Question: State the chart type depicted above.
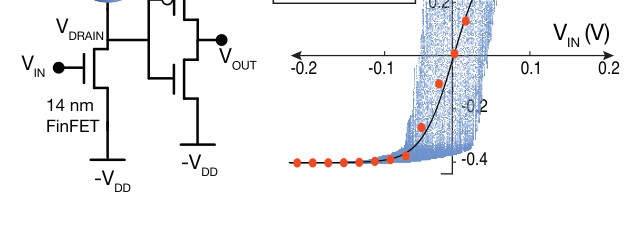
Answer: line